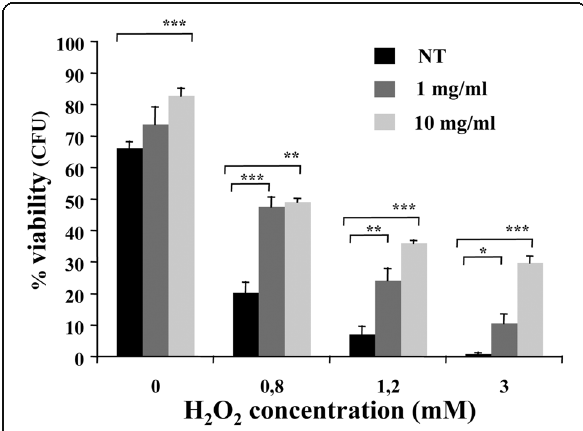
Fig. 3 Cell viability of Kllsm4 Δ 1 was measured after exposure to H 2 O 2 at the indicated concentrations for 4 h without (NT) or with apple extracts. Average of three independent experiments and standard deviation is reported. p -value: * <0.05; ** <0.01;